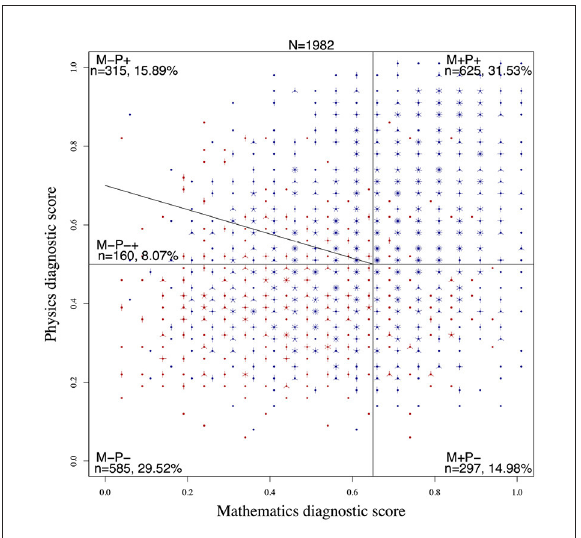
FIGURE1 Sunflower plot of initial state data (Mathematics and Physics diagnostic scores) from 2006 to 2010 with group labels, counts, and percent of the total number of students. There were N Mathematics and Physics diagnostic tests. The number n (lowercase) in each subgroup (M+P+, M and M+P ) indicates the number of students in that subgroup. − We also indicate the percentage of these numbers out of the total number N . Whenever data points with “S” and “U” grades overlapped, we added a slight offset for